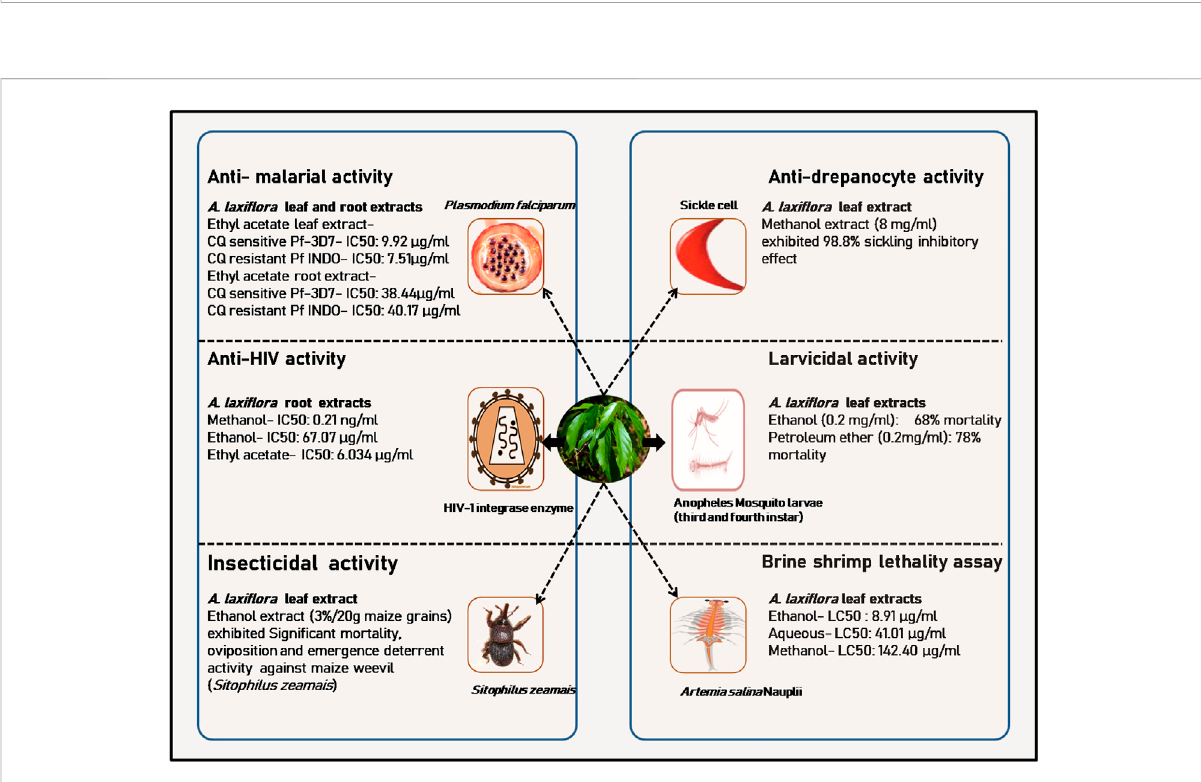
FIGURE 5 A few in vitro pharmacological and toxicological activities of A. laxi fl ora derived from Ogbole et al. (2016), Okokon et al. (2017a; 2017b), Morah and Uduagwu (2017), Osabiya et al. (2017), Bamimore and Elujoba (2018), Siwe-Noundou et al. (2019), and Ileke et al. (2020).